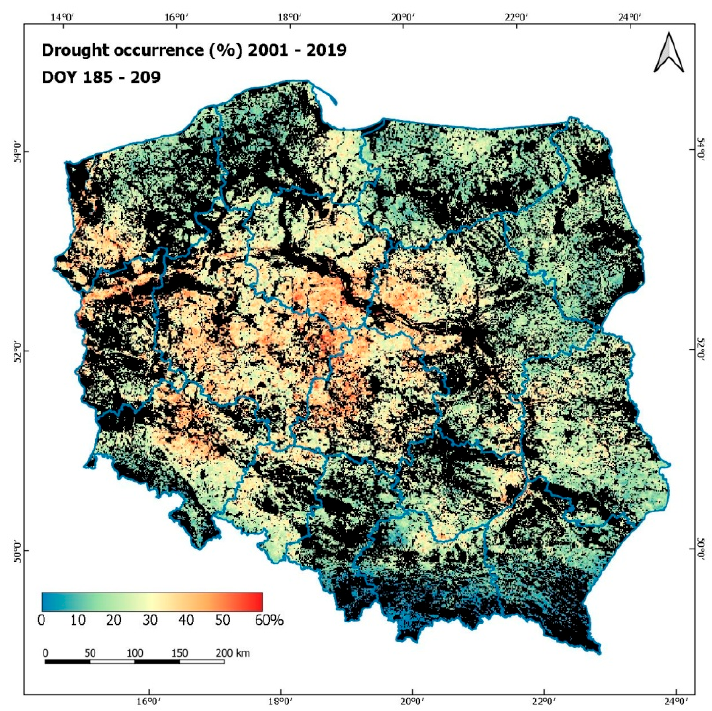
Figure 28. Percentage of drought occurrence in the 2001–2019 period (July 03–July 27).